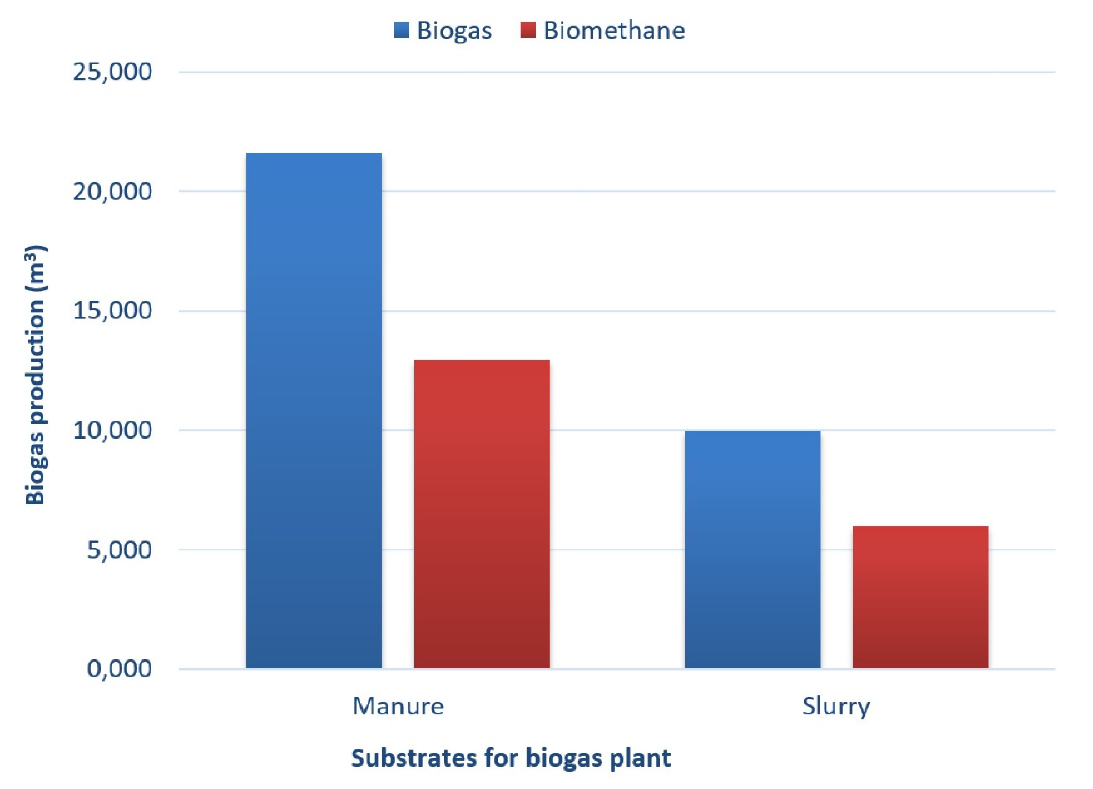
Energies 2021 , 14 , x FOR PEER REVIEW 13 of 25 Figure 4. Biogas and biomethane production from 20 cows on farmland. Own study based on Source: [41].